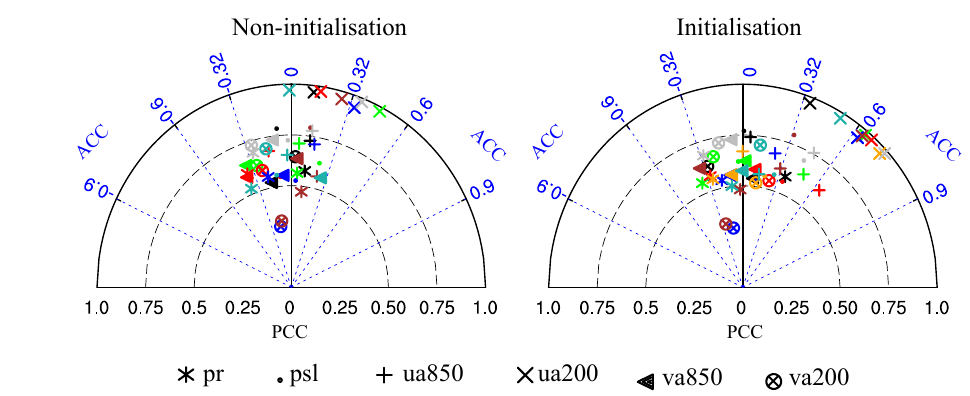
Figure 2. Taylor diagrams displaying the pattern (PCC) and temporal (ACC) correlation metrics of six variables between observation and model simulation in the EASM region (0–50 ◦ N, 100–140 ◦ E). Each coloured marker represents a model, i.e. the BCC-CSM1-1 (black), the CanCM4 (green), the GFDL-CM2p1 (red), the HadCM3 (blue), the MIROC5 (brown), the MPI-ESM-LR (light blue), and the HadCM3-ff (orange). The grey marker indicates the multi-model mean (MME).